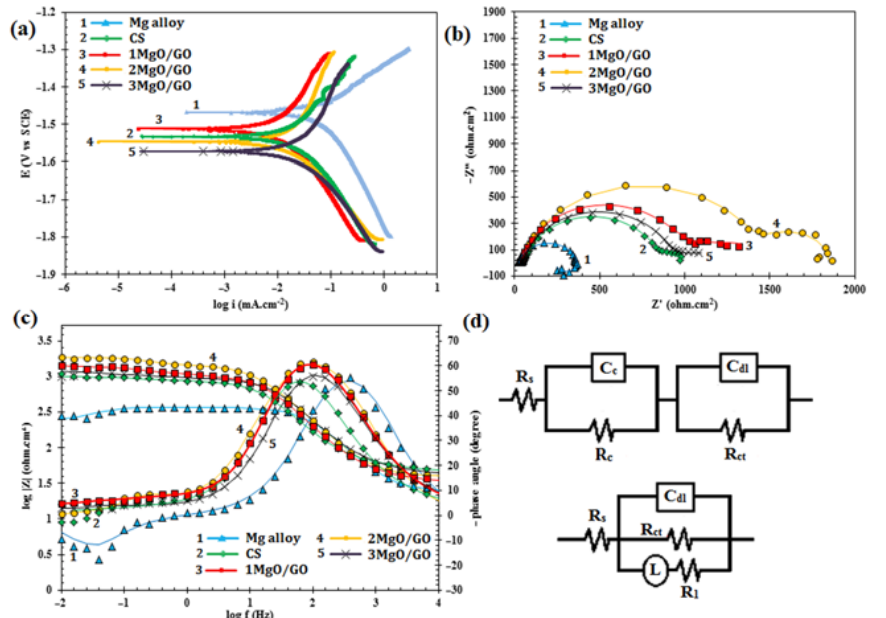
Figure 7. Electrochemical measurements of uncoated, CS, CS/1MgO-GO, CS/2MgO-GO, and CS/3MgO-GO coated Mg samples in m-SBF solution. ( a ) Potentiodynamic polarization curves; ( b ) Nyquist plots and ( c ) representative impedance (Bode magnitude and phase) spectra; and ( d ) equivalent circuit for impedance spectra.